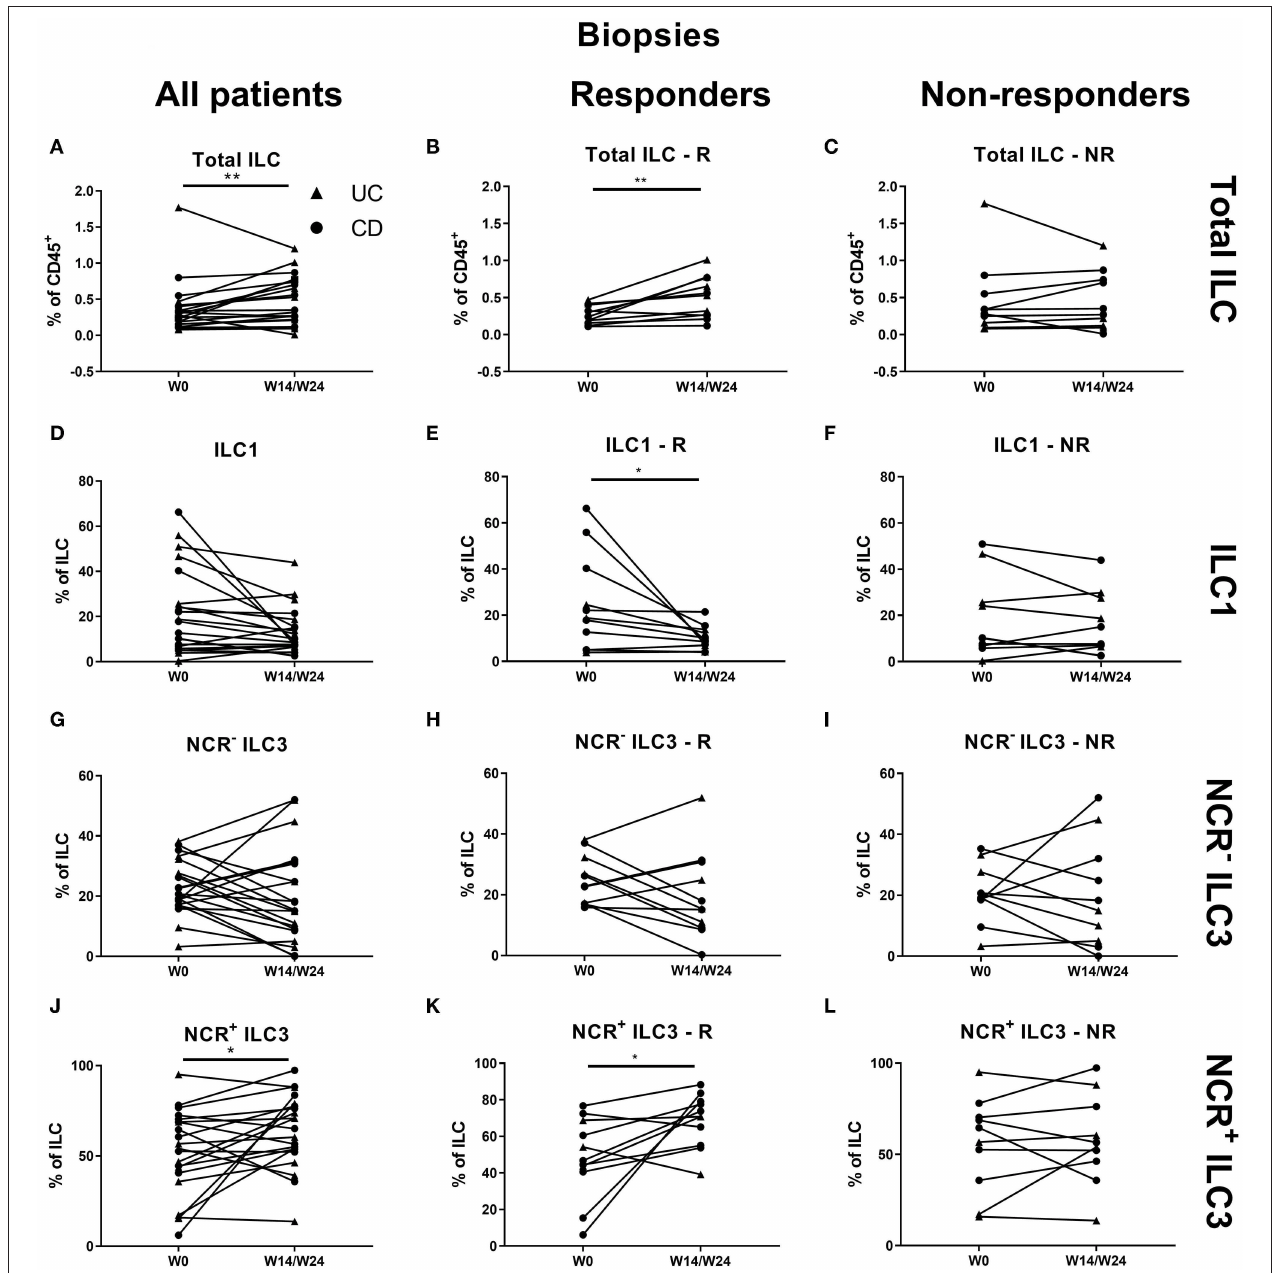
FIGURE 7 | Effect of vedolizumab therapy on intestinal ILC and ILC subsets. Twenty-one patients initiating vedolizumab treatment were followed up for 14 (UC, 1 )/24 (CD, • ) weeks and subdivided into responders (R, n = 11) and nonresponders (NR, n = 10) based on endoscopic evaluation. Paired analysis of total ILC as proportion of CD45 + leukocytes in all patients (A) , R (B) and NR (C) . Paired analysis of ILCI as proportion of total ILC in all patients (D) , in R (E) and in NR (F) . Paired analysis of NCR − ILC3 as proportion of total ILC in all patients (G) , in R (H) and in NR (I) . Paired analysis of NCR + ILC3 as proportion of total ILC in all patients (J) , in R (K) and in NR (L) . Wilcoxon paired-match testing (D–L) ; * p < 0.05, ** p ≤ 0.01. NCR, natural cytotoxic receptor; ILC, innate lymphoid cell; CD, Crohn disease; UC, ulcerative colitis.